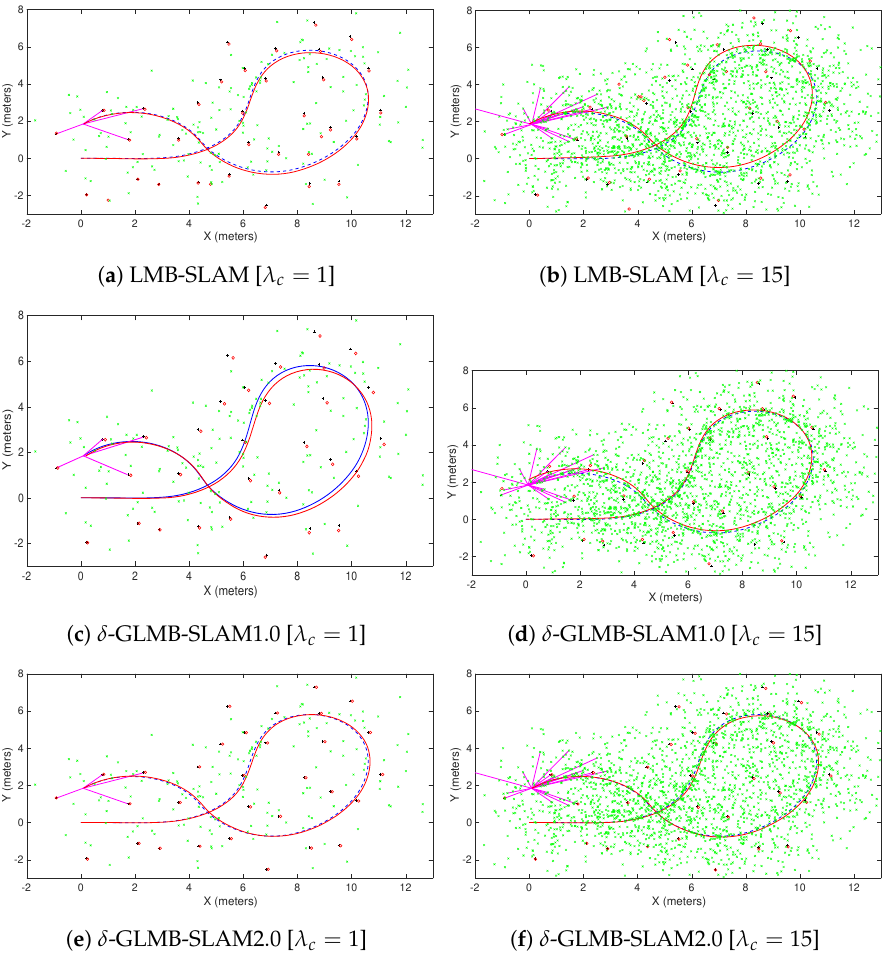
Figure 1. A comparison of the estimated robot trajectory (red) superimposed on the ground truth robot trajectory (dashed blue) for varying clutter conditions. The black plus signs represent the actual feature positions and the red circles represent the estimated feature positions. The green crosses represent accumulated measurement clutter and the magenta lines correspond to feature